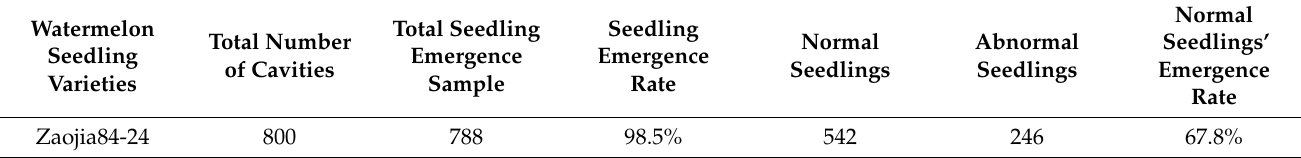
Table 1. Sample data statistics.